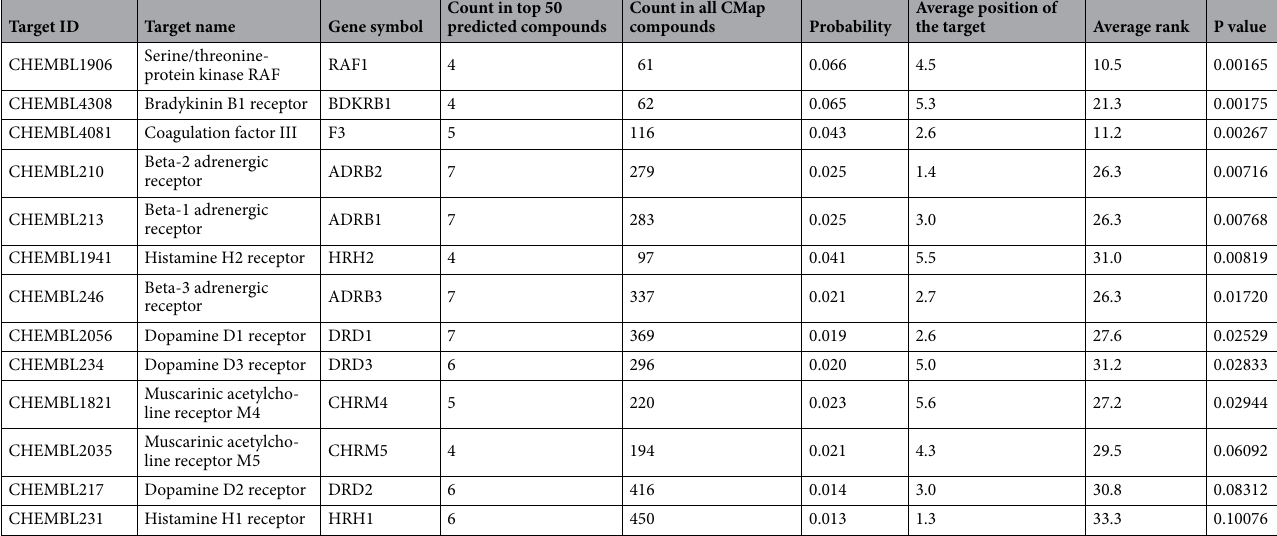
Table 2. Most enriched protein targets in the top results. Frequency of all predicted protein targets were counted in the top 50 results compared to all compounds in the Connectivity map database. Probability of observing each protein target (count in top 50/count in all compounds) is displayed as Probability. P value displays significance of observing each target in the top results compared to all the compound signatures extracted from CMap (5,764 signatures). Average position of the target denotes average rank of the protein target for the top 50 compounds using in silico target